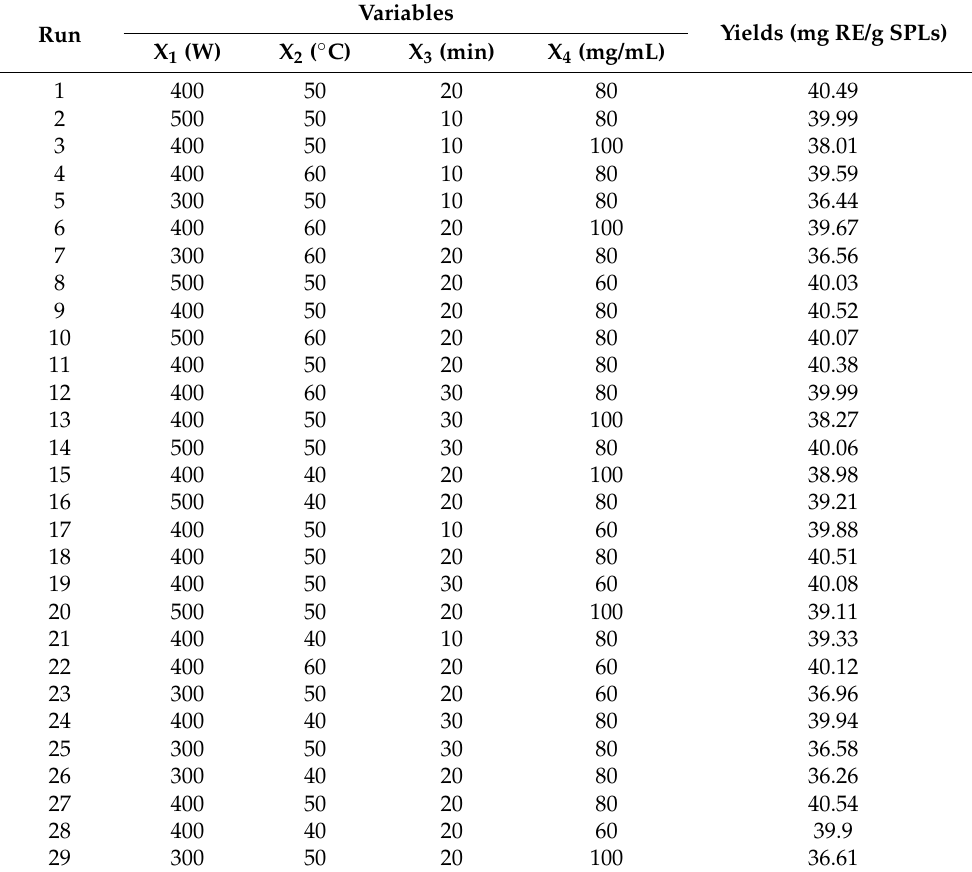
Table 4. Results of the Box–Behnken design for extraction optimization. Run